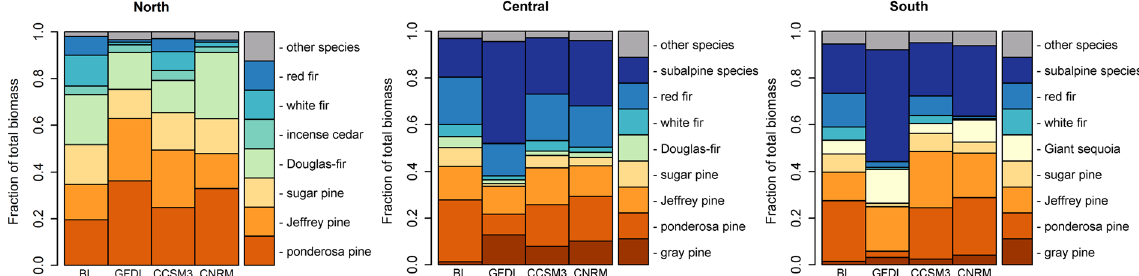
Figure 4. Distribution of aboveground carbon among dominant tree species. Mean fraction of aboveground carbon by dominant tree species at the end of the 590-year simulation under baseline climate and wildfire scenario (BL) and projected climate and wildfire scenario of each model (GFDL, CCSM3, CNRM) across the three transects. Values are means across replicate